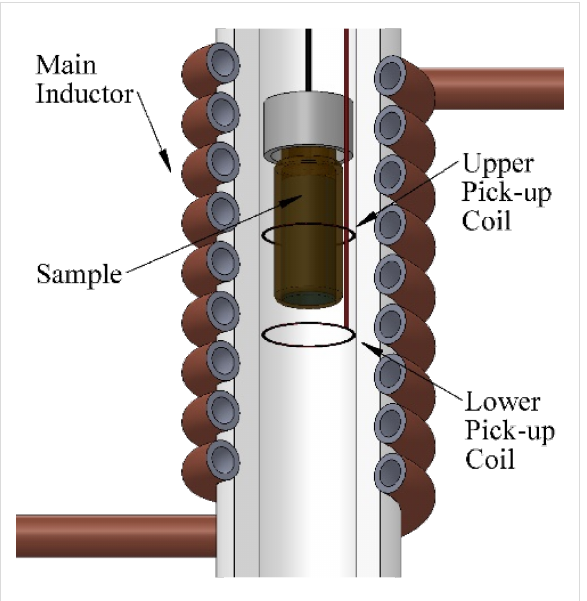
Figure 7: Scheme of the AC magnetometer with the air-core coil and the oppositely wound pick-up